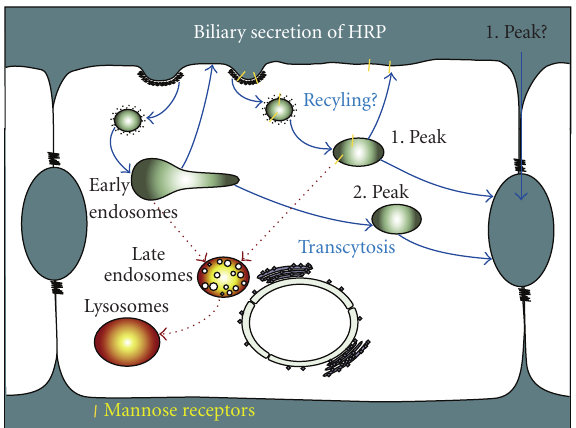
Figure 5: Scheme of potential pathways involved in HRP secretion into bile. Compartments labeled by HRP are indicated by blue color. Although HRP is also directed to lysosomes, only those endosomes involved in transcytosis are shown in blue. MRs (yellow bars) presumably recycle back to the sinusoidal plasma